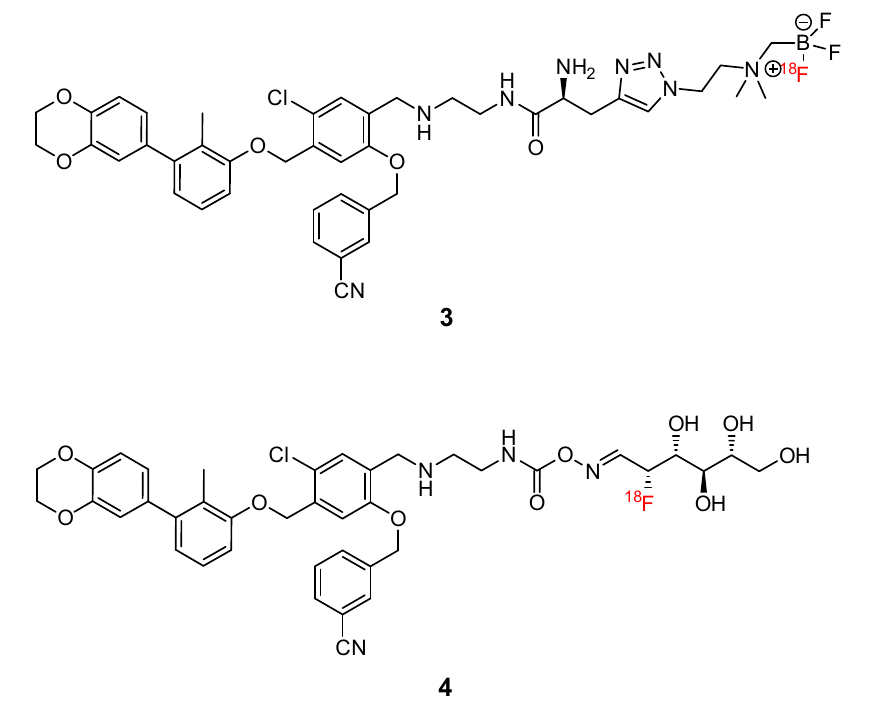
Figure 11. Chemical structures of radiofluorinated small molecule inhibitors [64,65].